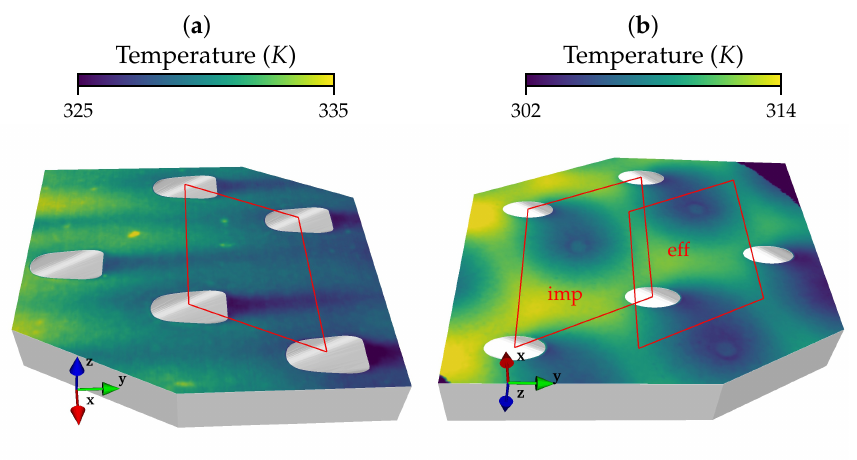
Figure 4. FE model for heat flux computation: left side ( a ) top view; right side ( b ) bottom view. Averaging areas for evaluation shown in red. Color shows mapped temperature from thermography of a case with H = 5 D , MALO00